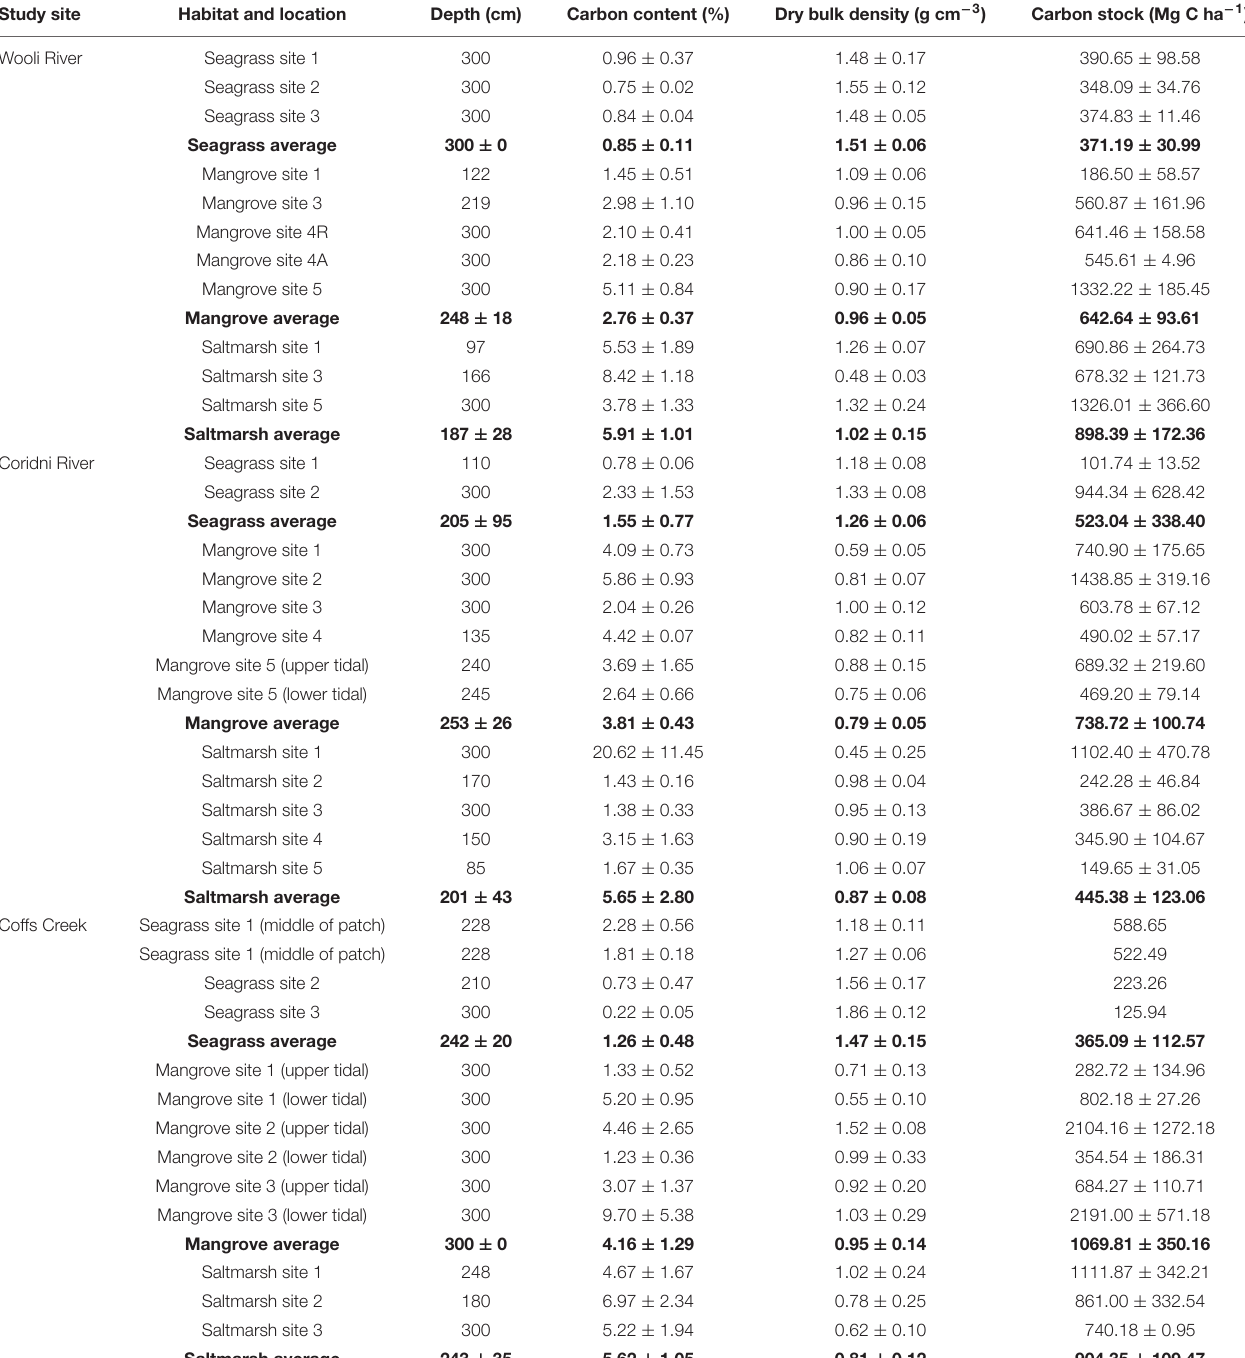
TABLE 2 | Depth (cm), C content (%), dry bulk density (g cm − 3 ), and C stocks (Mg C ha − 1 ) for seagrass, mangrove, and saltmarsh cores collected from Wooli and Corindi River estuaries. Study site Habitat and